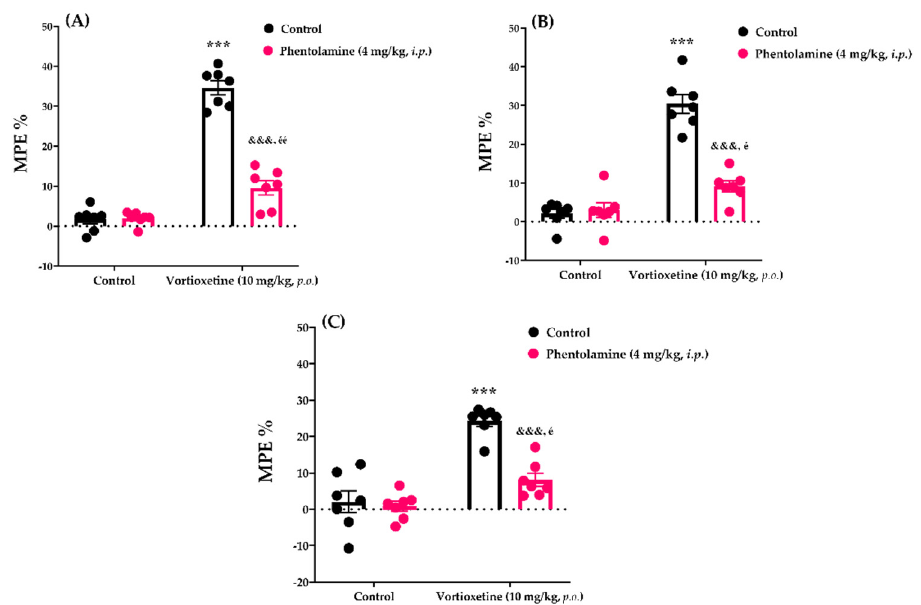
Figure 8. Involvement of α -adrenergic receptors in the analgesic effects of vortioxetine in the tail- clip ( A ), tail-immersion ( B ) and hot-plate ( C ) tests. Significant difference against vehicle treated control groups *** p < 0.001; Significant difference against vortioxetine administrated control groups &&& p < 0.001; Significant difference against phentolamine administrated control groups é p < 0.05, éé p < 0.01. Two-way ANOVA, post-hoc Bonferroni test, n = 7.